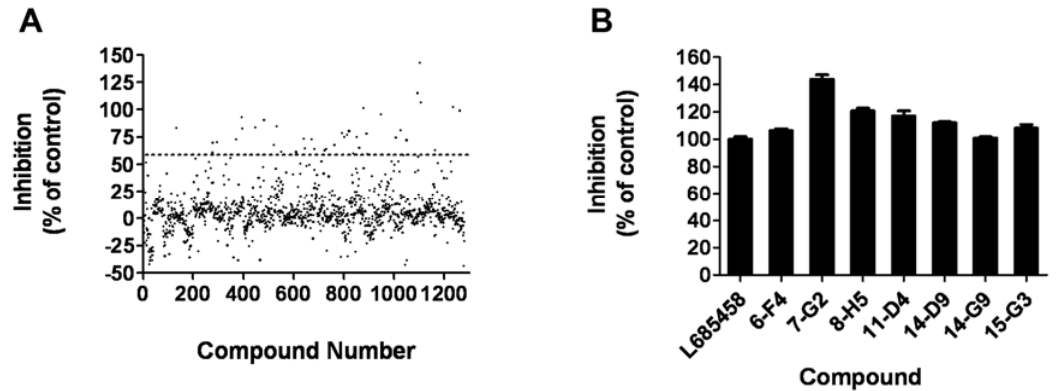
Figure 5. High-throughput screening of 1280 compounds. (A) Result of the primary screening of 1280 compounds in duplicate setup with HEK293T membrane. Compounds with more than 60% inhibition of the γ -secretase were further tested. (B) In the